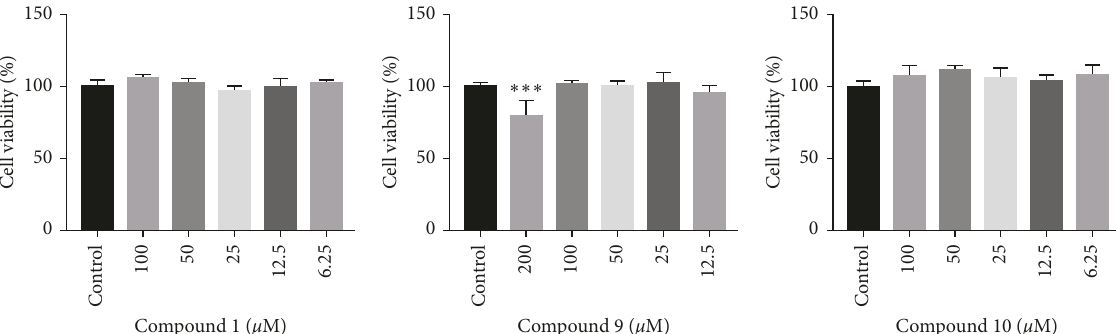
P 0 . 001, and compared with the LPS group, ∗∗∗ <